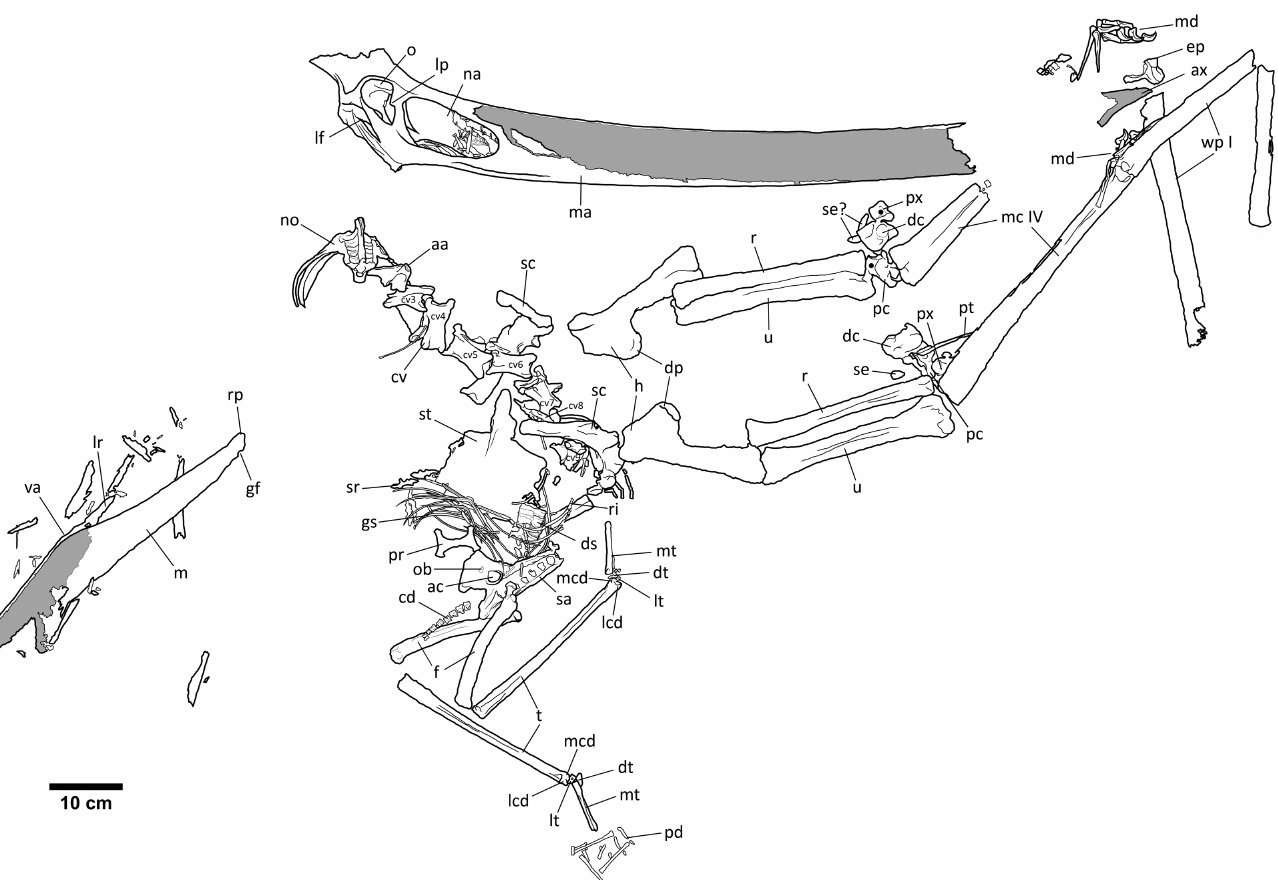
Figure 2. Outline diagram of UALVP 24238. Abbreviations: aa, atlas-axis complex; ac, acetabulum; ax, possible apex of the rostrum; cv, cervical vertebra; cd; caudal vertebra; dc, deltopectoral crest; dc, distal syncarpal; dp, deltopectoral crest; ds, dorsal vertebra; dt, distal tarsal; ep, extensor tendon process; f, femur; gf, glenoid fossa; gs, gastralia; h, humerus; lcd, lateral condyle; lf, lower temporal fenestra; lp, lacrimal process; lr, left mandibular ramus; lt, lateral tarsal; m, mandible; ma, maxilla; mc, metacarpal; mcd, medial condyle; md, manual digit; mt, metatarsal; na, nasoantorbital fenestra; no, notarium; o, orbit; ob, obturator foramen; pc, proximal syncarpal; pd, pedal digit; pr, prepubis; pt, pteroid; px, preaxial carpal; r, radius; ri, rib; rp, retroarticular process; sa, synsacrum, sc, scapulocoracoid; se, sesamoid; sr, sternal rib; st, sternum; t, tibiotarsus; u, ulna; va, ventral mandibular angle; wp, wing phalanx. Circular black dots on the pc and px represent the position of pneumatic foramina. Grey areas represent portions of the rostrum and mandible that are composed of extremely thin trabecular